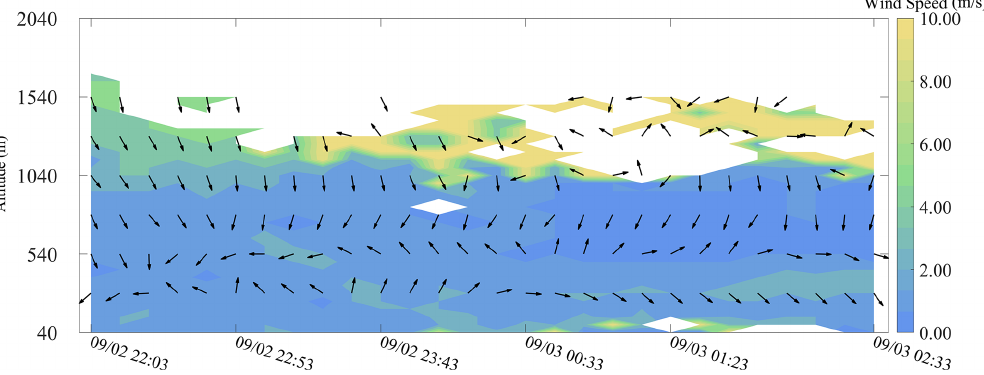
Figure 6. Wind speed and wind direction of Type I. Colour map represents horizontal wind speed (m/s). Arrows represents the wind